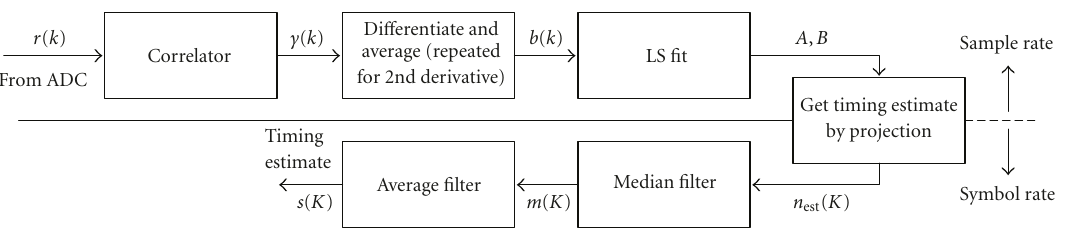
Figure 3: Block diagram of the timing